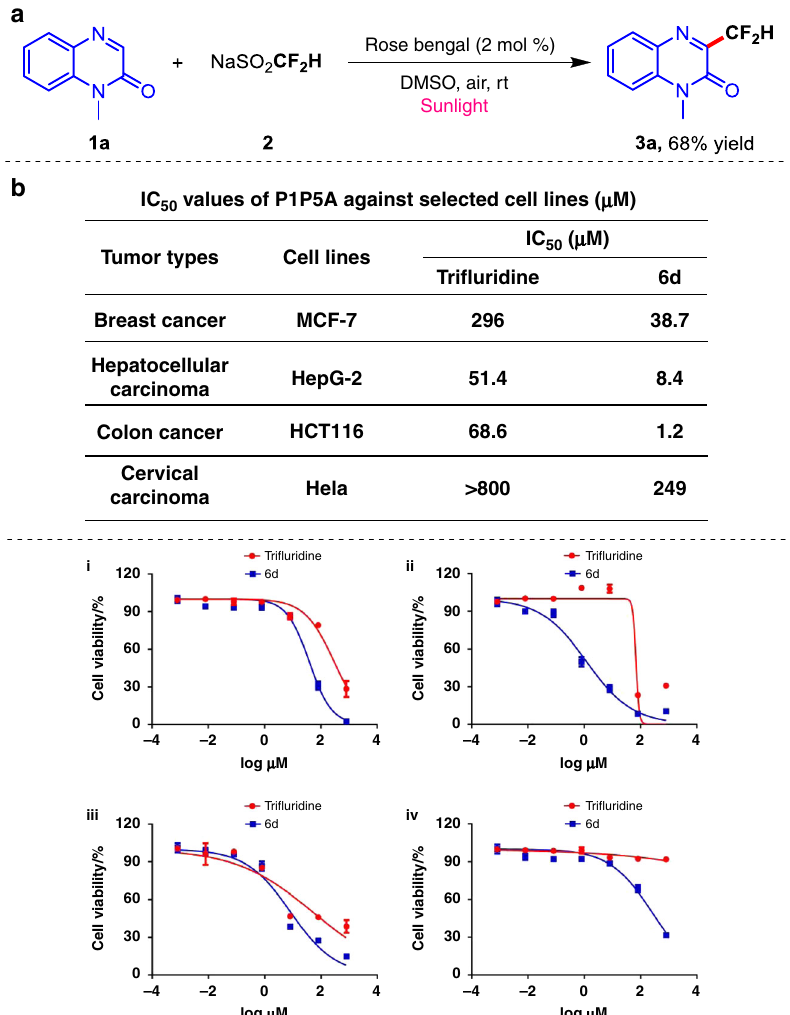
Fig. 6 Synthetic applications. a The reactions were carried out with 4 (0.1 mmol), CF 2 HSO 2 Na 2 (0.2 mmol), rose bengal (2 mol%) in 1 mL DMSO under sunlight irradiation at room temperature. b Cytotoxicity of compounds. i MCF-7 (human breast adenocarcinoma cells), ii HepG-2 (human liver hepatocellular carcinoma cells), iii HCT116 (human colorectal cancer cells), and iv Hela (human cervical carcinoma cells) were treated with various concentrations of each compound for 72 h. Cell death was then measured by using a CCK-8 assays ( n = 5, mean ±